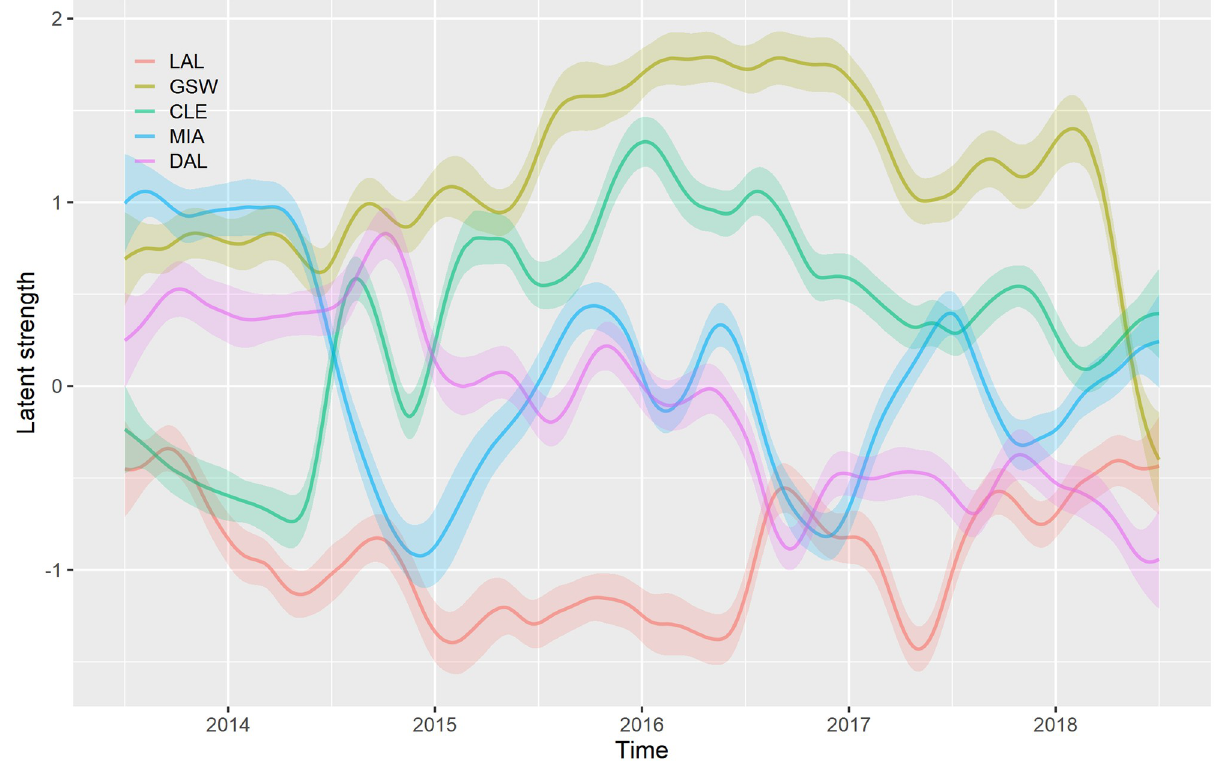
Fig 4. Comparison of latent strengths of selected five NBA teams using the GP prob model. For each team a line and a ribbon are shown which represent a posterior mean and the corresponding standard deviation. The Golden States Warriors (GSW) were for most of the period the best out of these five teams. A drop can be seen in Miami Heat’s (MIA) strength going from the 2014 to the 2015 season, while the Cleveland Cavaliers’s (CLE) strength increases. These changes correspond with LeBron James leaving Miami Heat and returning to Cleveland